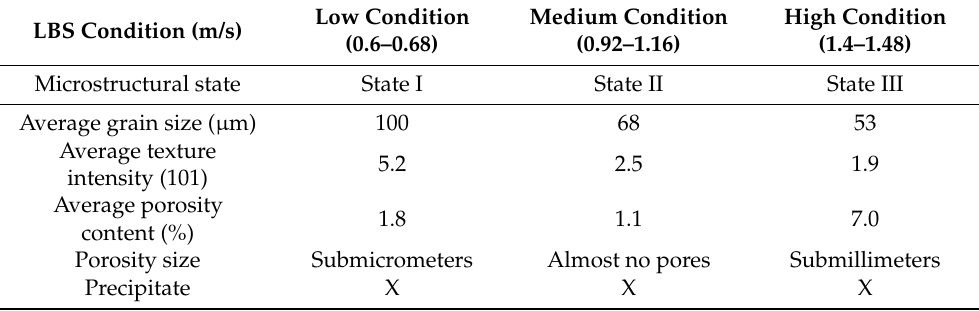
Table 1. Microstructures according to the varying LBS conditions characterized using metallog- raphy.